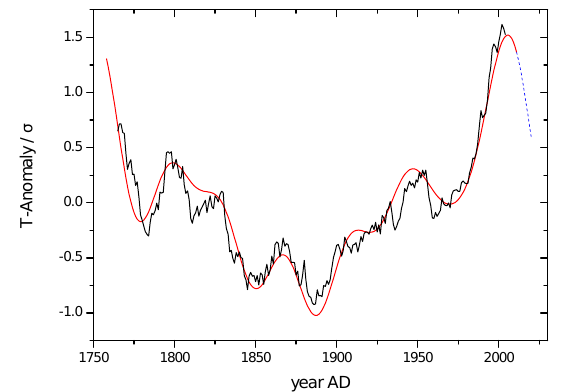
Fig. 6. (color online) 15yr running average record SM6 (black); re- construction RM6 according to Eqs. (1), (3) and (4) (red); projection of future NH temperatures mainly due to the ∼ 65-yr periodicity (dashed